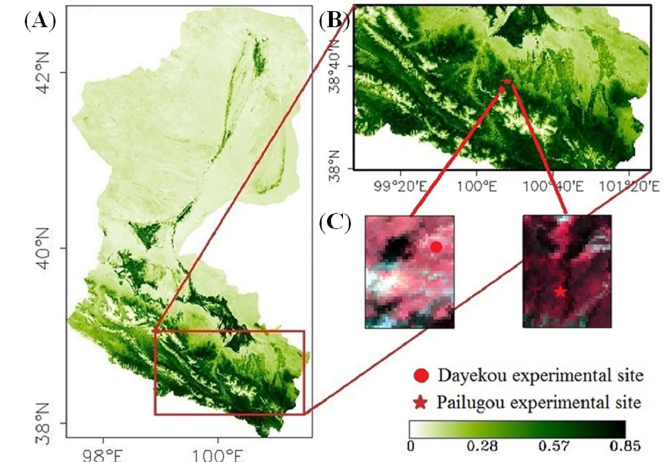
Figure 2. Map of the Heihe River Basin ( A ); study area ( B ); and Dayekou and Pailugou experimental sites (the two small false color images) ( C ). The map is from MODIS NDVI on 27 June 2008. The false color image is from Hyperion on 15 June 2008 with resolution of 30 m, within a 0.01° × 0.01°